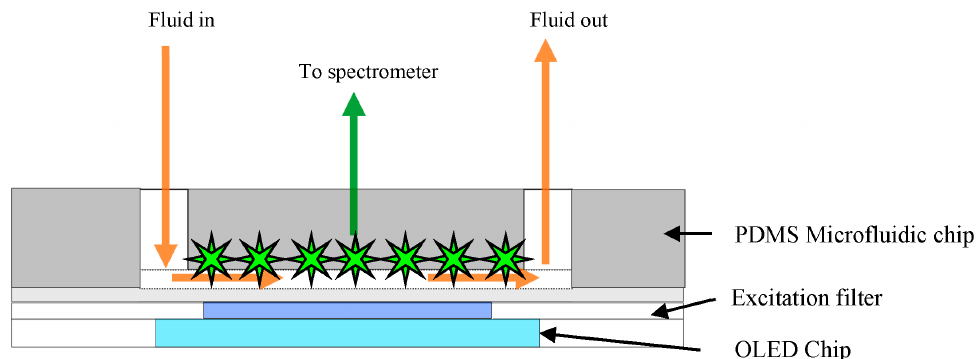
Figure 5. OLED source-filter-chip-detector setup.